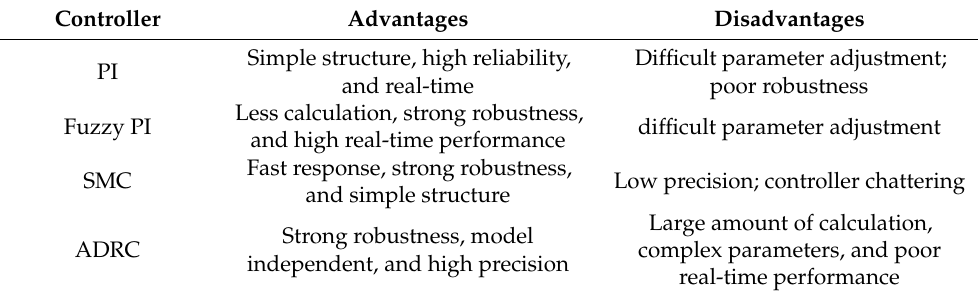
Table 1. Performance comparison between different